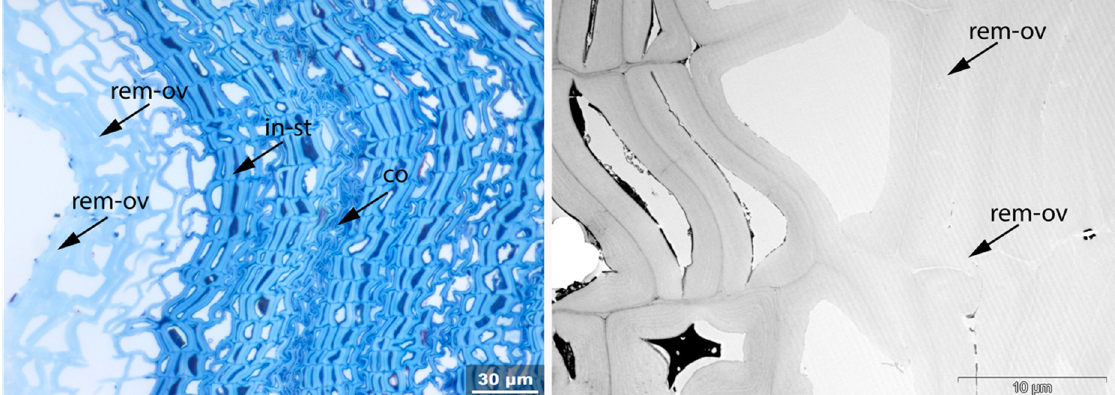
Figure 23. Sample 10. Left: LM. Loss of phenolic compounds from cell wall layers and lumen is visible in left outer bands (rem-ov). Deeper layers are unchanged and display birefringence (not shown). Thin-walled cell walls are compressed (co). In transition zone between bleached and unchanged phellem a slight swelling (swe) and increased blue staining (in-st) of secondary cell wall is visible. Right: TEM. Overall loss of phenolic components is significant and a change in appearance of the thin lamella structure of secondary cell wall is visible.